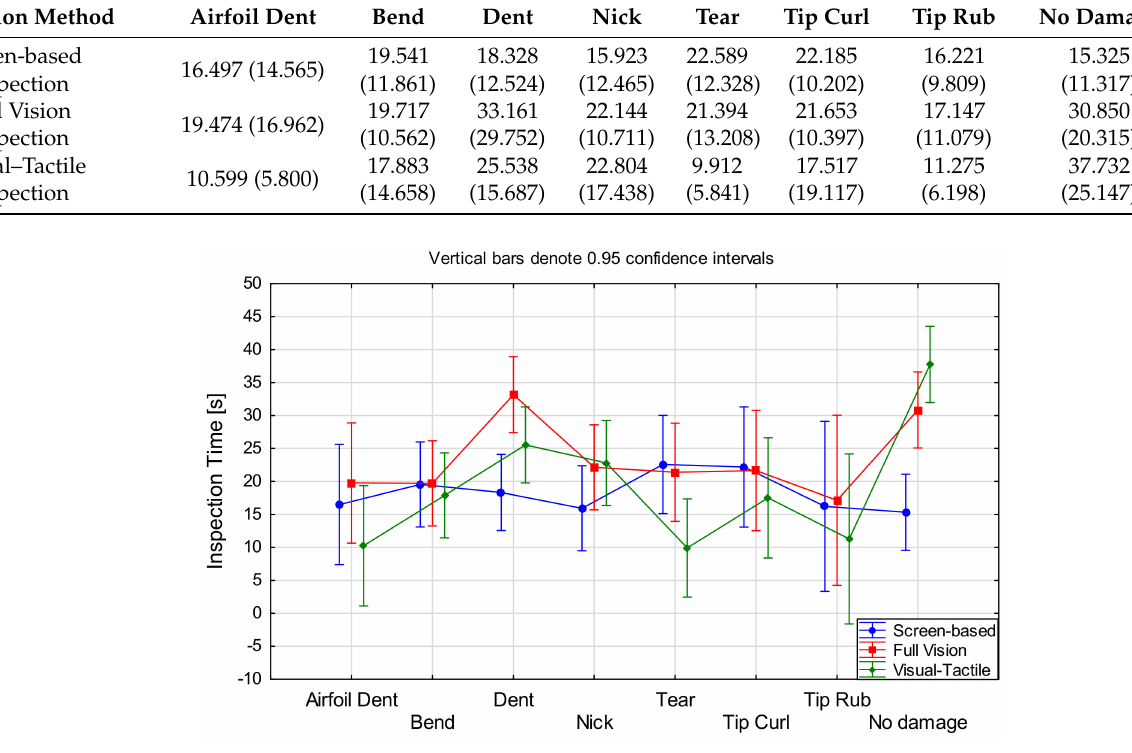
Figure 8. Mean plot of inspection time by defect type for all inspection